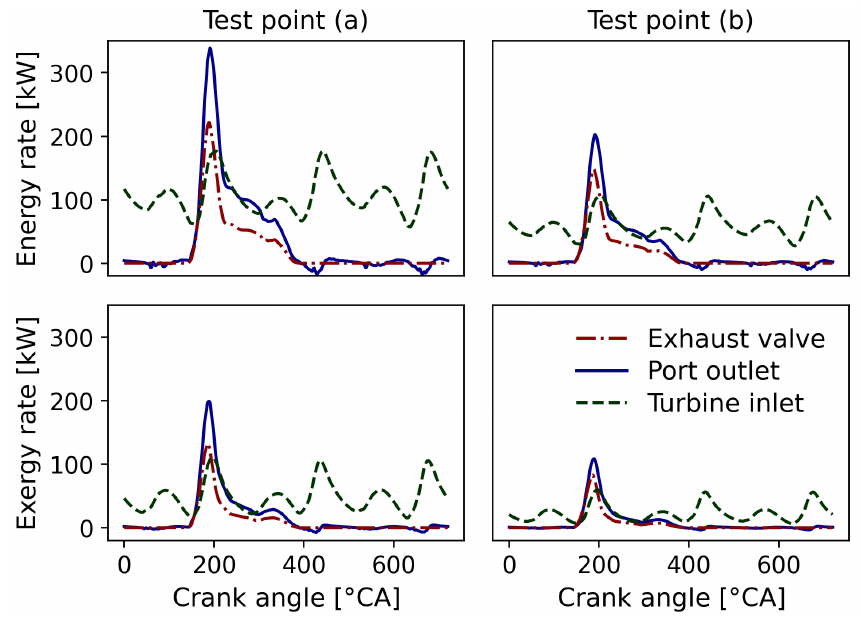
Figure 6. Flow enthalpy and exergy of exhaust pulsations at three measurement positions operating at test points: (a) 1300 rpm/17.8 nIMEP; (b) 900 rpm/11.5